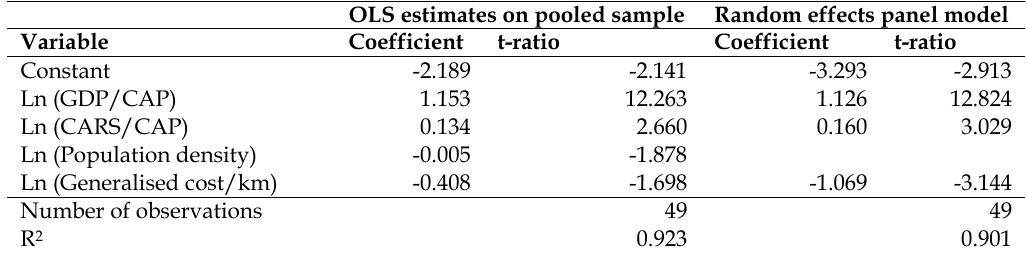
Table 2. Country estimation results for passenger-kilometres model OLS estimates on pooled sample Random effects panel